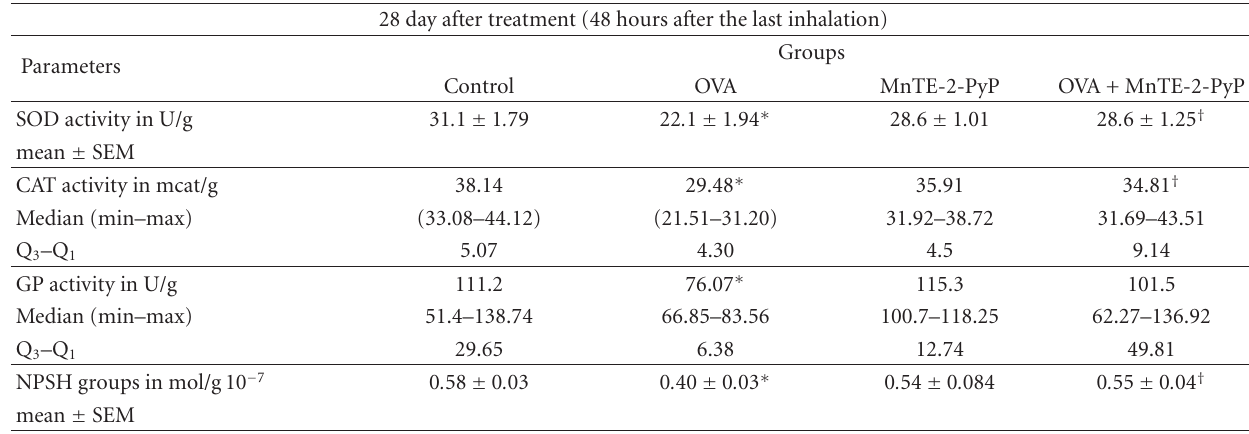
Table 2: E ff ect of MnTE-2-PyP on the activity of some enzymes of lung antioxidant defence system in mice asthma model. 28 day after treatment (48 hours after the last inhalation)